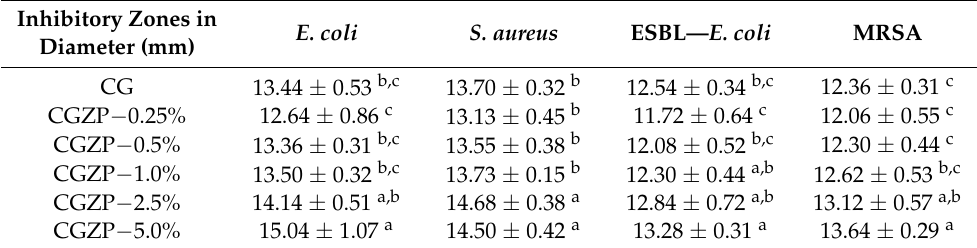
Figure 6. Photographs of inhibitory zones ( a ) and bacterial colonies ( b ) of CG and CGZP films against E. coli , S. aureus , ESBL— E. coli , and MRSA, ( c ) quantitative statistics of antibacterial effectiveness of colony counting method, and different letters in the columns indicate significant differences ( p < 0.05). Table 3. Inhibitory zone diameters of the films against different bacteria.